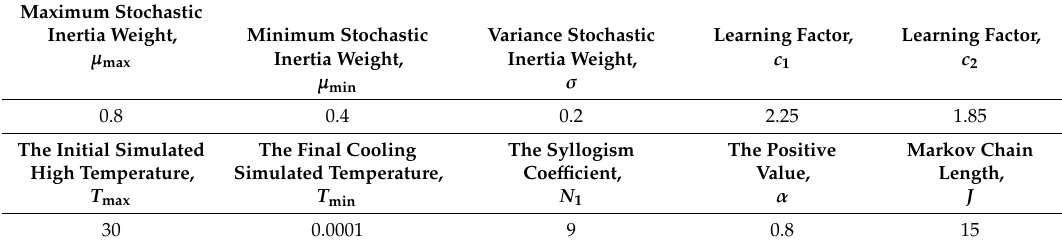
comparison with the other two algorithms. Table 1. Coe ffi cients of three algorithms based on particle swarm optimization (PSO).